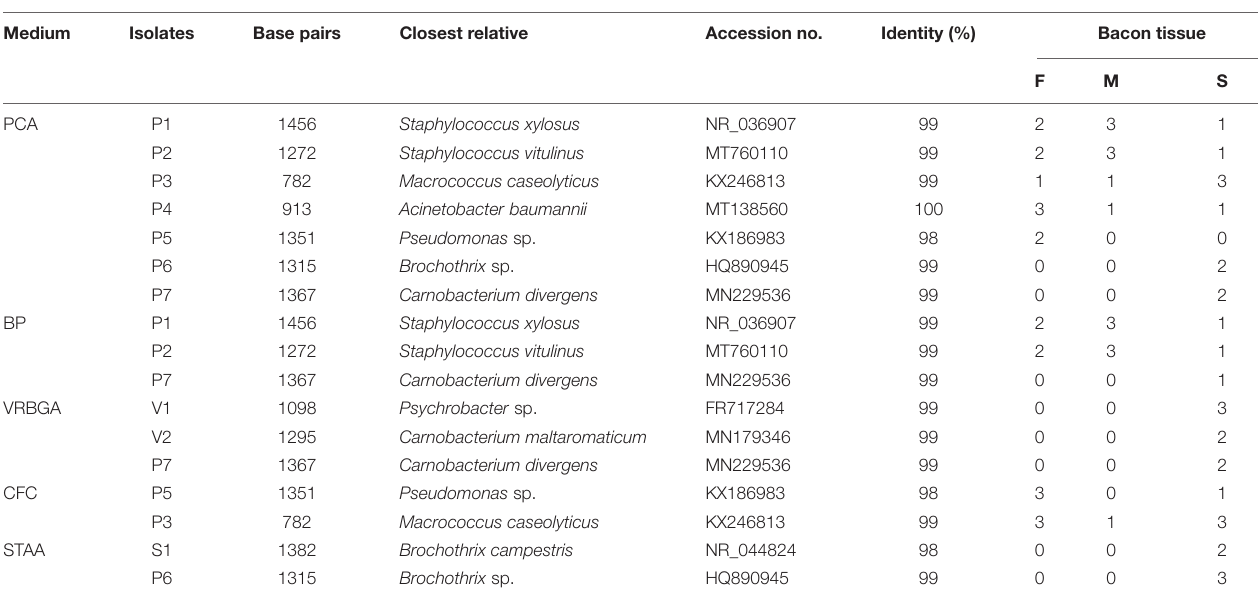
TABLE 2 | Identification of isolates based on 16S rRNA gene sequencing